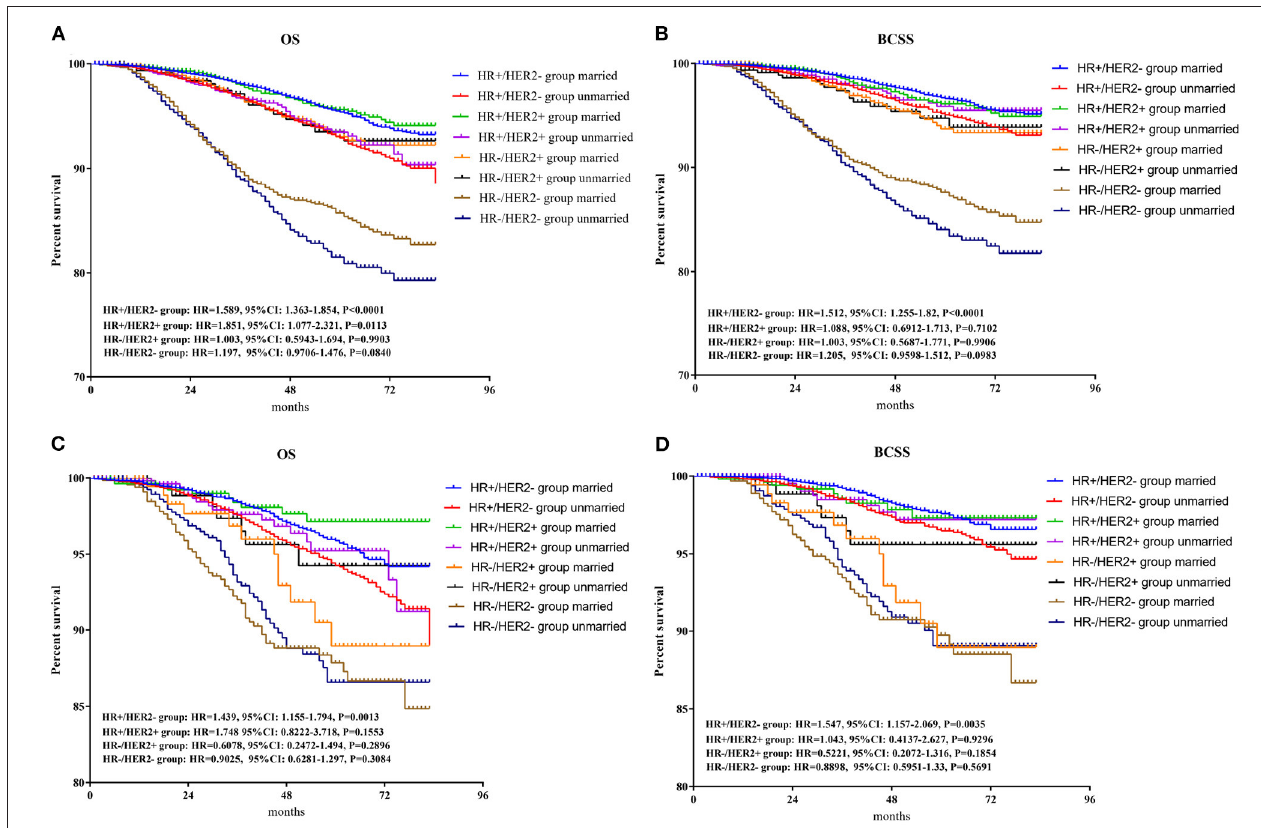
FIGURE 5 | Survival analysis of OS and BCSS between married and unmarried patients in HR + /HER2 + , HR + /HER2–, HR–/HER2 + , and HR–/HER2– subgroups. BCSS, breast cancer-specific survival. (A) Overall survival for patients before PSM; (B) breast cancer-specific survival for patients before PSM; (C) overall survival for patients after PSM; (D) breast cancer-specific survival for patients after PSM. PSM, propensity score